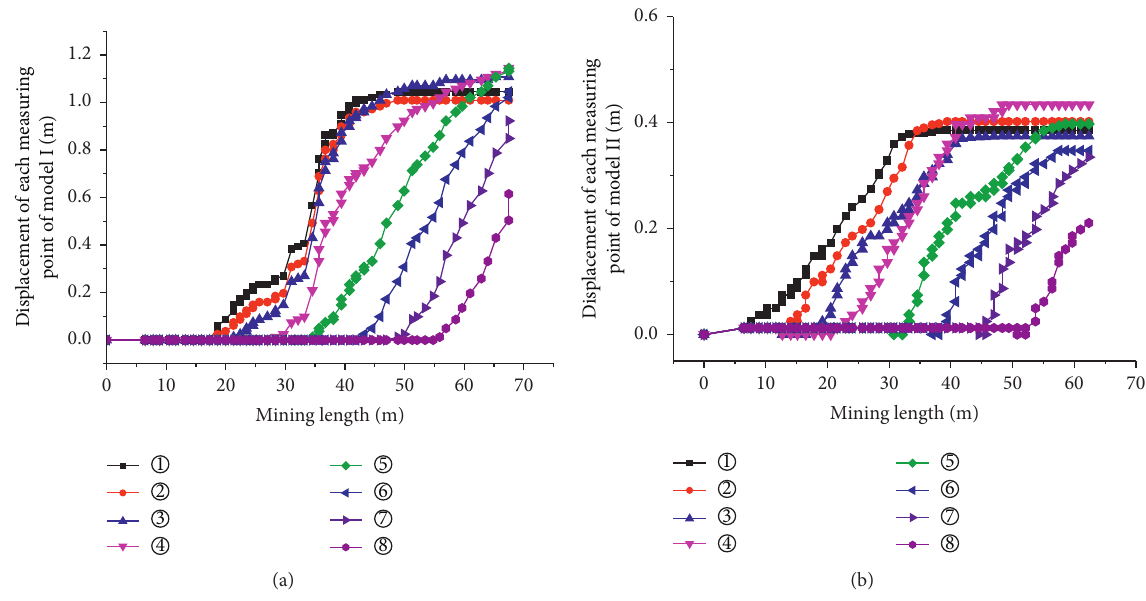
Figure 8: The displacements of the measuring points in the line 1 in the process of mining and filling: (a) model I and (b) model